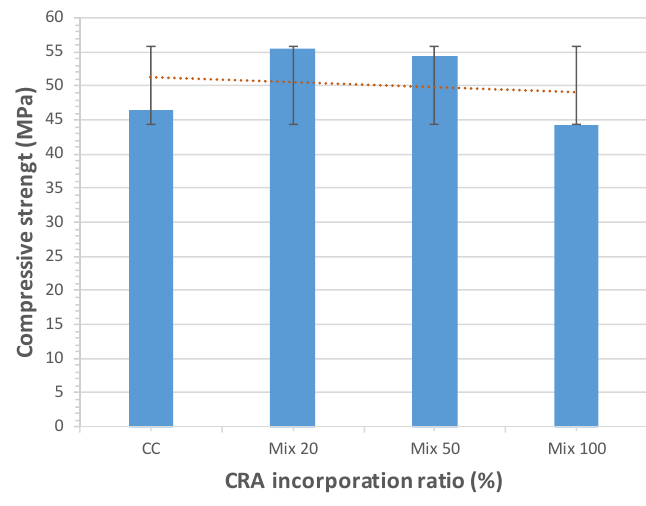
Figure 13. 28-day compressive strength results.